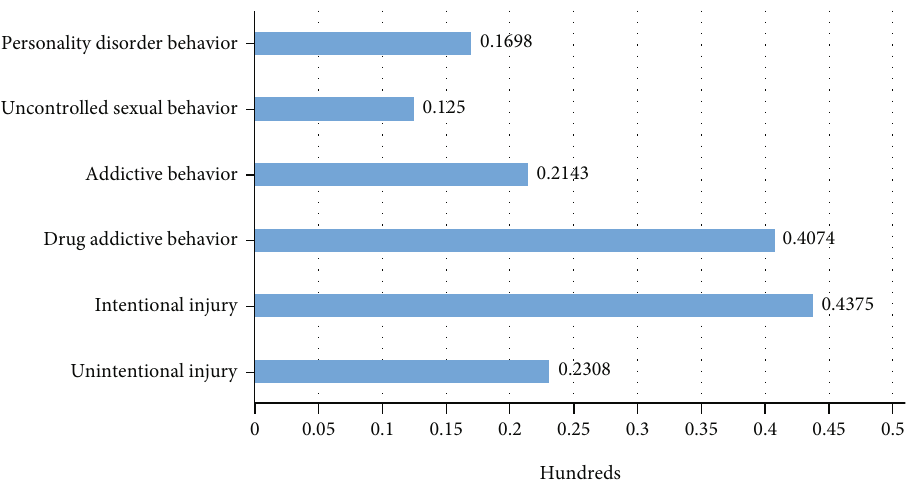
Figure 4: Visualization of AHRB behavior of non-AHRB